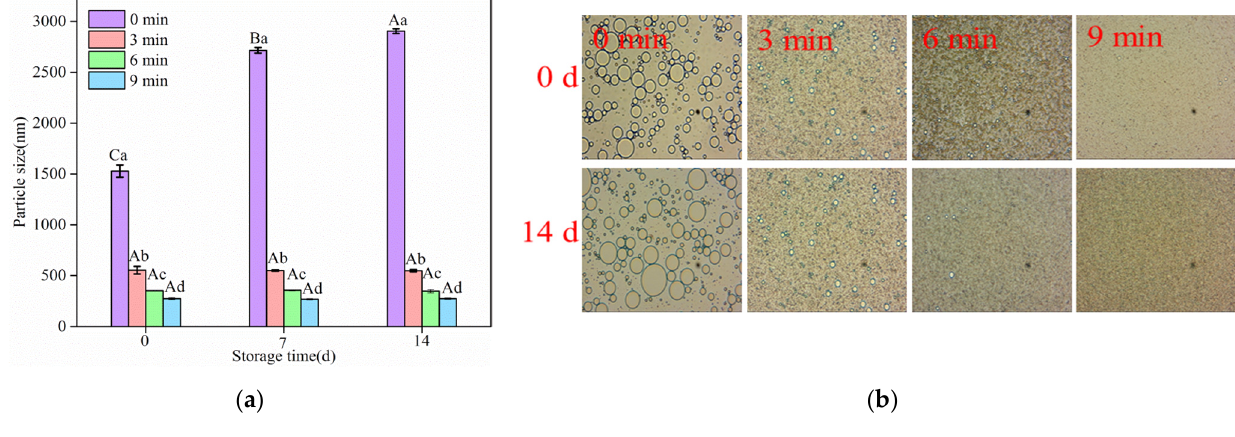
Figure 6. Changes in the particle size and microstructure of SC-coated O/W emulsions at different storage times. ( a ) Particle size; ( b ) microstructure; a–d: different letters indicate significant differences among the means within the same storage time ( p < 0.05). A–C: different letters indicate significant differences among the means within the same ultrasound time ( p < 0.05).